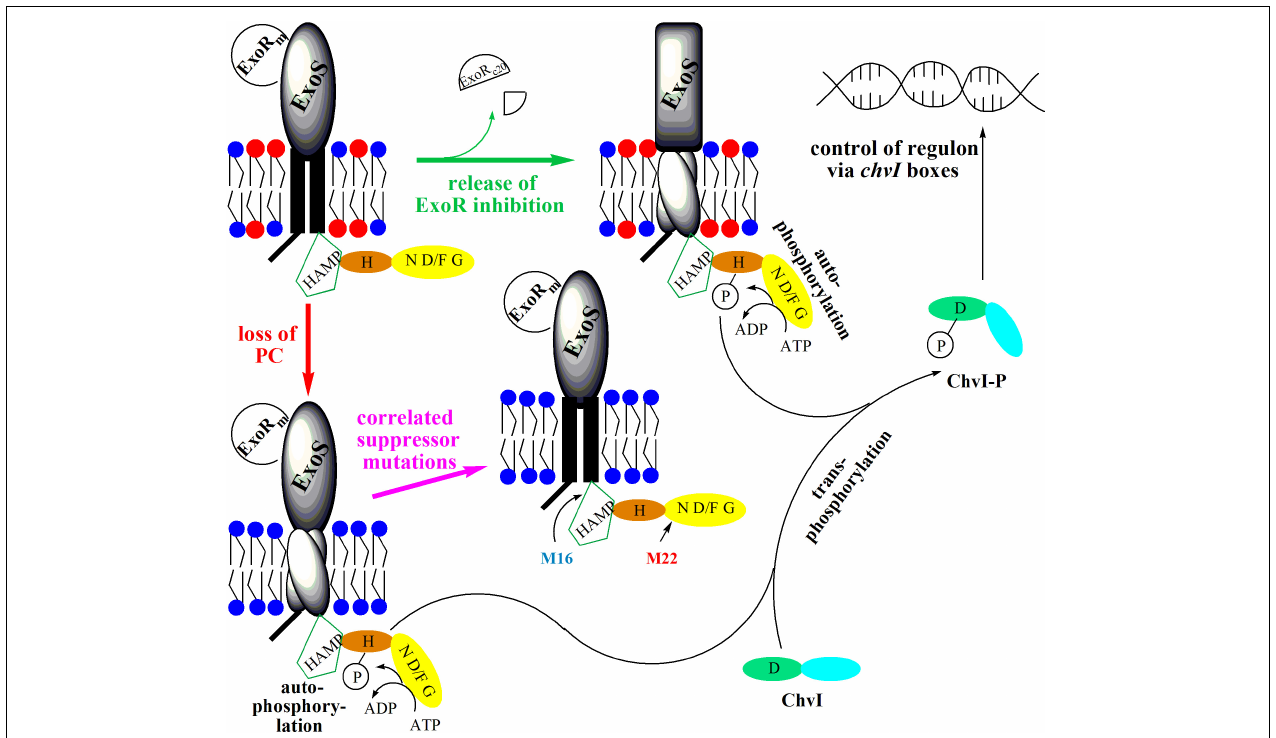
FIGURE 11 | Model for the activation of sensor kinase ExoS by release of ExoR inhibition or by loss of PC from the membrane. In free-living S. meliloti bacteria, the two-component regulatory system ExoS/ChvI, remains inactive due to binding of the periplasmic inhibitor protein ExoR m to the ExoS sensor kinase. Upon contact of S. meliloti with its legume host, ExoR m is proteolytically degraded, forming ExoR c20 , thereby eliminating the inhibition of ExoS and triggering autophosphorylation of ExoS on the conserved H368 residue. Subsequently, the ExoS transphosphorylation activity phosphorylates the conserved D52 residue of the ChvI response regulator. Phosphorylated ChvI-P alters transcription of more than 100 genes, leading for example to the formation of more succinoglycan, less flagellar proteins and to reduced swimming capability. Loss of PC from the membrane probably provokes rearrangement of transmembrane helices 1 and 2 of ExoS, thereby triggering conformational change and activation of the cytoplasmic domain of ExoS. Autophosphosphorylation of ExoS followed by transphosphorylation to ChvI results also in production of more succinoglycan and reduced swimming. Correlated suppressor mutations in M16 (I315T) or M22 (G475S) render the cytoplasmic ExoS domain into a more inactive conformation avoiding autophosphorylation of ExoS, transphosphorylation to ChvI and formation of phosphorylated ChvI-P. Therefore, correlated suppressor mutants M16 and M22 display wild type-like succinoglycan production and swimming behavior. The ExoS protein from S. meliloti comprises 595 amino acid residues and contains an N-terminal cytoplasmic domain (residues 1-47), transmembrane helix 1 (residues 48-68), a periplasmic domain (residues 69-278), transmembrane helix 2 (residues 279-299), and a C-terminal cytoplasmic domain (residues 300-595). Within the cytoplasmic domain, a HAMP-domain (residues 301-357) and a histidine kinase domain (residues 365-593) can be distinguished. The HAMP domain is considered crucial for dimerization of sensor kinase monomers and for functionality of the sensor. The histidine kinase domain comprises the conserved H368-containing H box (residues 361-380), as well as the nucleotide binding cleft defined by several conserved amino acids motifs, the N box (residues 473-494), the D/F box (residues 513-540), and the G box (residues 549-567). PC is highlighted by a red circle for its head group, whereas head groups for PE and other membrane lipids are represented by a blue